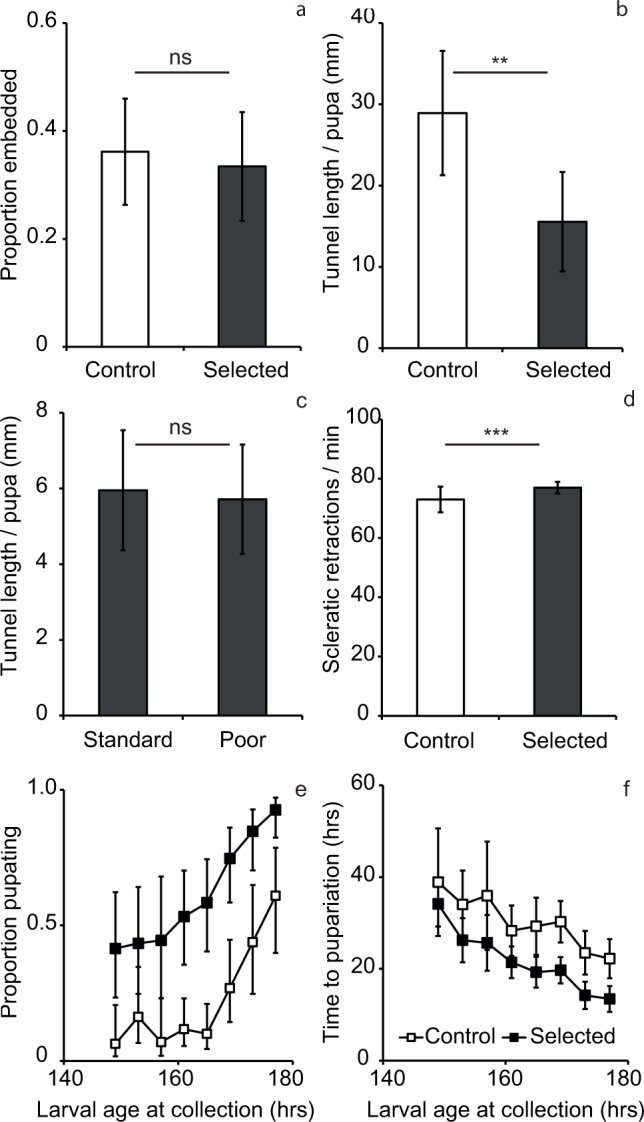
Building behavior traits in malnutrition tolerant selected populations (dark symbols) compared to unselected controls (white symbols).(a) The proportion of pupae that embedded in the agar substrate and (b) the average tunnel length per embedded pupa for the selected and control populations; N = 3 assay plates per population. (c) The effect of food quality on average tunnel length per embedded pupa for the selected populations. (d) Tunneling effort measured as the rate of scleratic retractions per minute, N = 8 larvae per population. (e-f) Assay of the interval between larval wandering forays and pupariation: (e) The proportion of larvae collected outside of food which succeeded to pupariate in the absence of food as a function of age at collection (logistic ANCOVA: slope F
1,81 = 110.8, P < 0.0001, regime F
1,10 = 22.9, P < 0.001). (f) The time between collection and pupariation as a function of age at collection (ANCOVA: slope F
1,67 = 112.0, P < 0.0001, regime F
1,10 = 27.7, P < 0.001). In all panels the error bars indicate 95% confidence intervals, in panels a-d ‘ns’ indicates not significant while ‘**’ and ‘***’ indicate p < 0.01 and p > 0.001 respectively. Except as indicated in panel (c), all larvae used in these assays were raised on standard food.